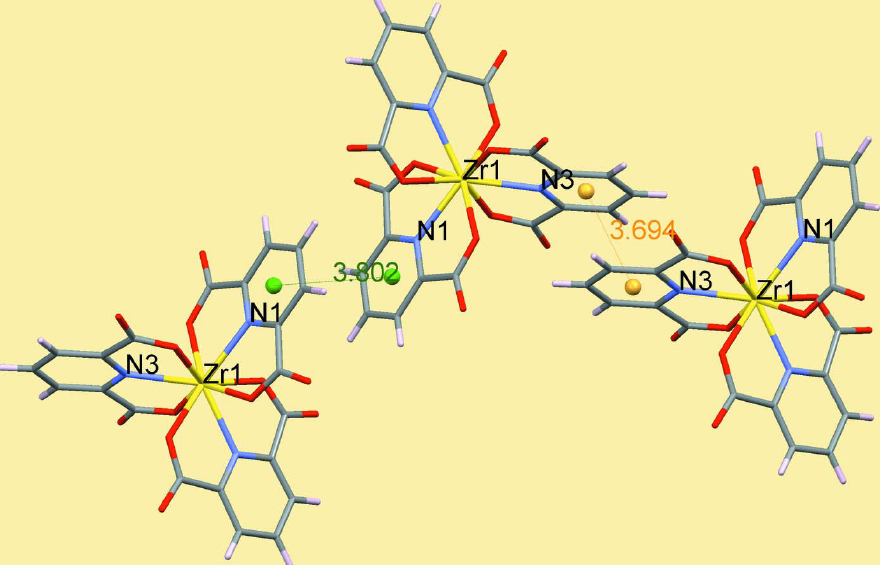
Figure 3 π - π stacking with centroid···centroid distances